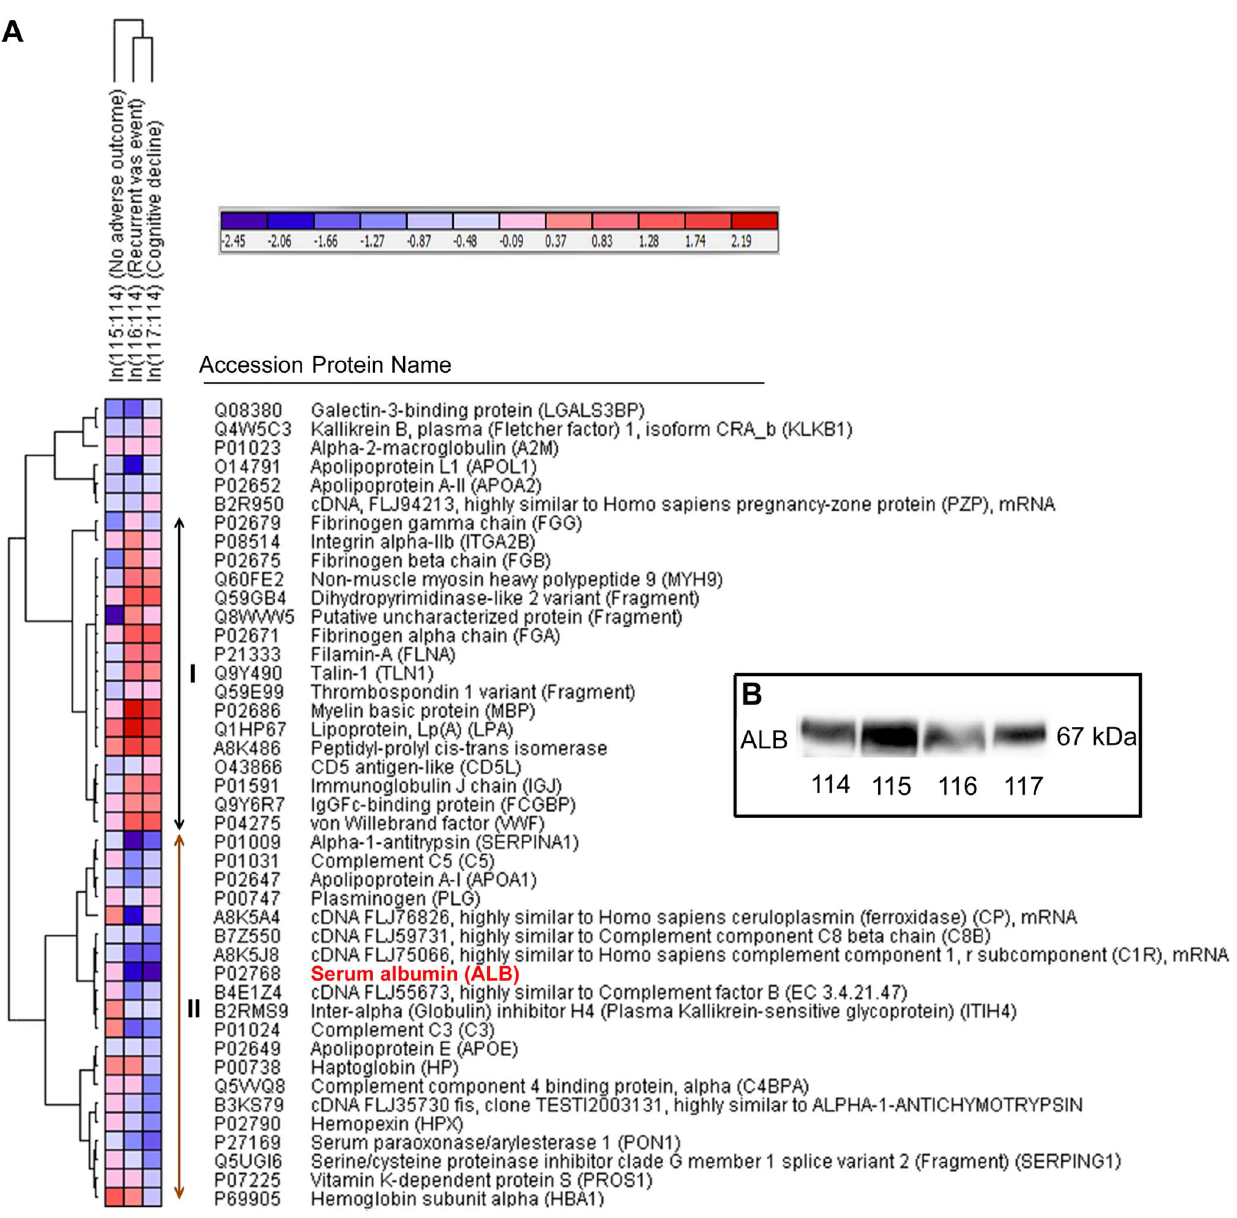
Figure 3. A) Hierarchical clustering of the filtered list of proteins from microvesicle-enriched plasma. Log 2 -transformed ratios (e.g. ln (115/114)) of each protein (row) were presented for all conditions (column). Pearson correlation was applied for the measurement of row and column distance. Globally normalized view was presented here. The color scale of the heat map ranges from saturated blue (value, 2 2.45) to saturated red (value, 2.19) in the natural logarithmic scale. The proteins were mainly clustered into two parts as shown by I (up-regulated in adverse outcome groups) and II (down-regulated in the adverse outcome groups). The pattern of regulation was similar between recurrent vascular event and cognitive decline group amid subtle differences in magnitudes. MBP and ALB were the two most regulated proteins. The protein names and accession numbers were taken from the uniprot protein database. The gene symbols are provided within brackets along with the protein name, wherever available. B) Technical validation of iTRAQ result by WB analysis of ALB on pooled lysates. ALB showed down-regulation in both LACI groups with adverse outcome, which is consistent with the iTRAQ result. binding protein, alpha) amid differences in magnitudes only. The hierarchical clustering analysis classified the proteins into However, the extent of deregulation is generally more for the two major clusters (Figure 3A, I and II) separating up- and down- regulated proteins in adverse outcome groups. A few trends were decline’ group (Table 2, Figure 4). This could indicate the apparent. First, the pattern of regulation of the significantly perturbed proteins in both groups with adverse outcome (recurrent remain at a subclinical stage in the patients with cognitive decline. vascular events and cognitive decline) was similar in most cases (except Fibrinogen gamma chain and Complement component 4